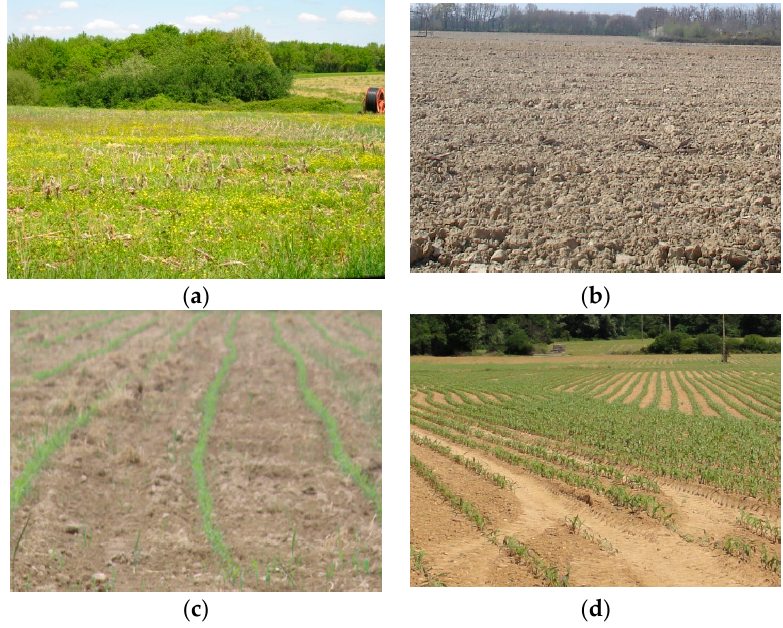
Figure 5. Examples of observed surface states in early spring: ( a ) vegetated soil (crop regrowth and self-sown plants); ( b ) bare soil; ( c ) emergence; ( d ) vegetated soil (corn at first phenological stage).